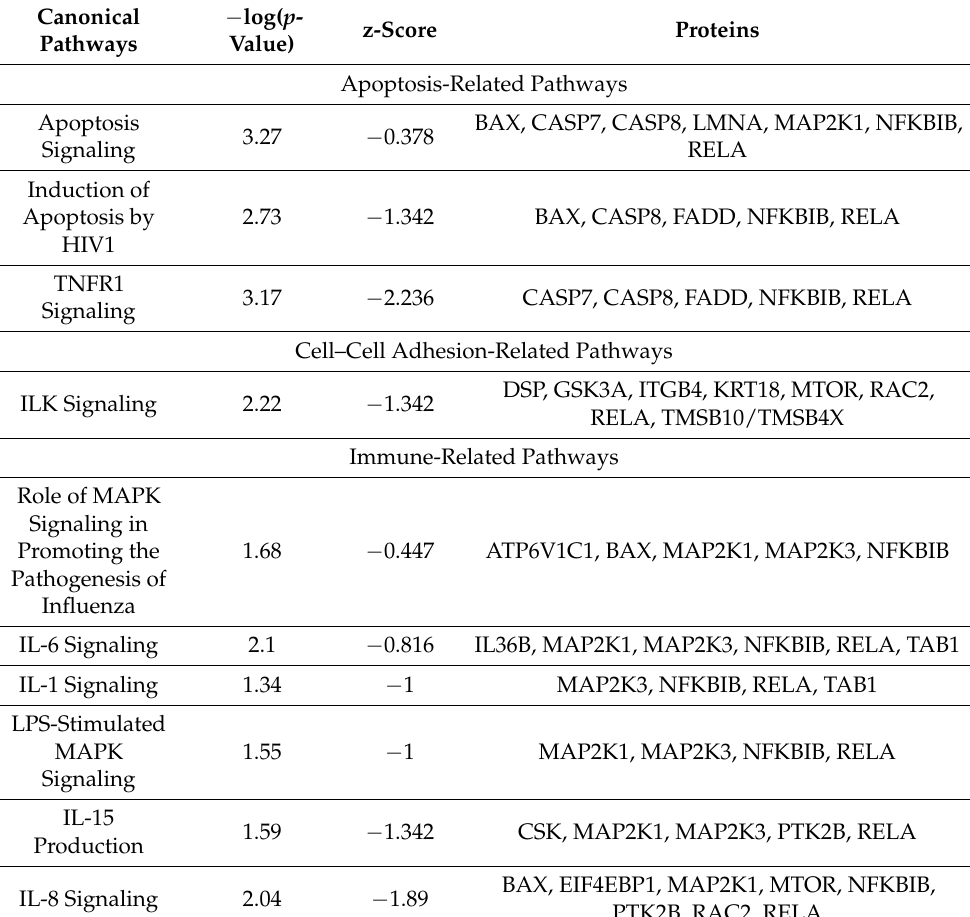
Table 2. Canonical Pathways for the 10 µ g/mL of Nicotine vs. PBS with Negative